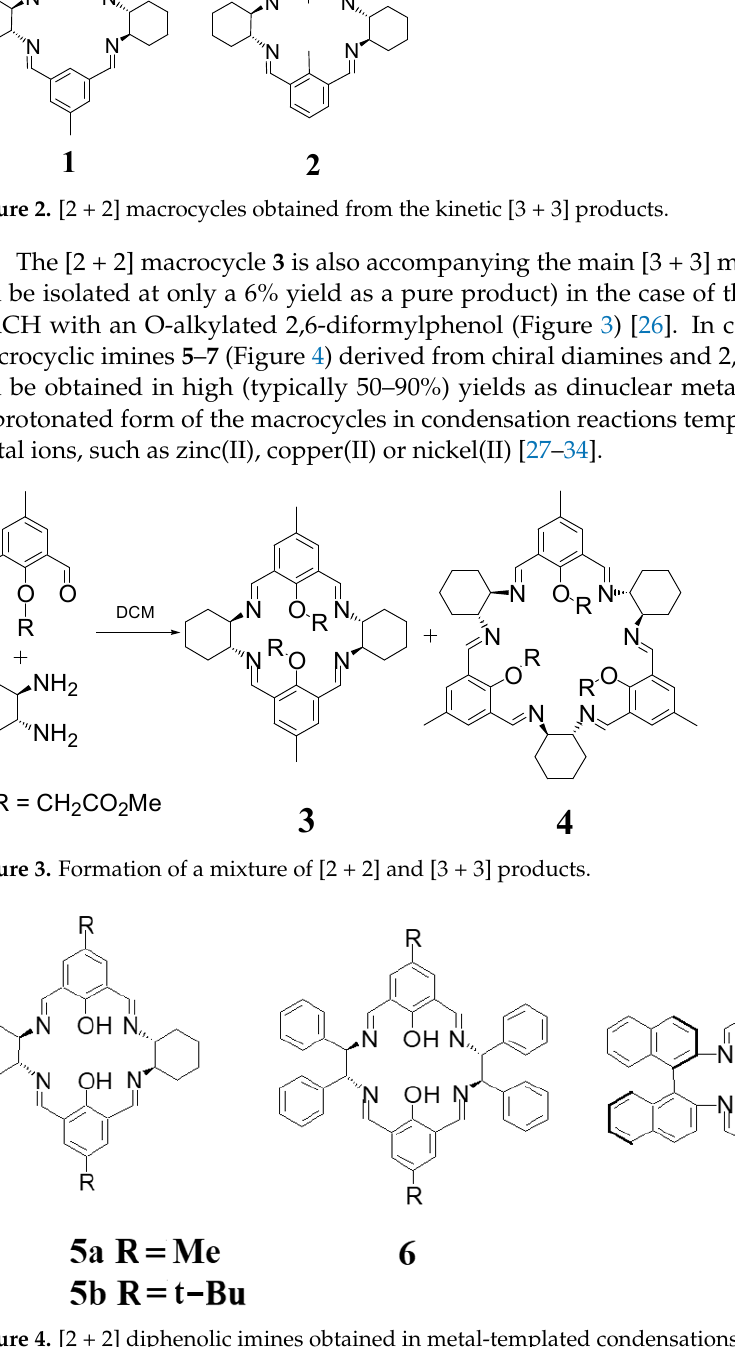
Figure 4. [2 + 2] diphenolic imines obtained in metal-templated condensations.